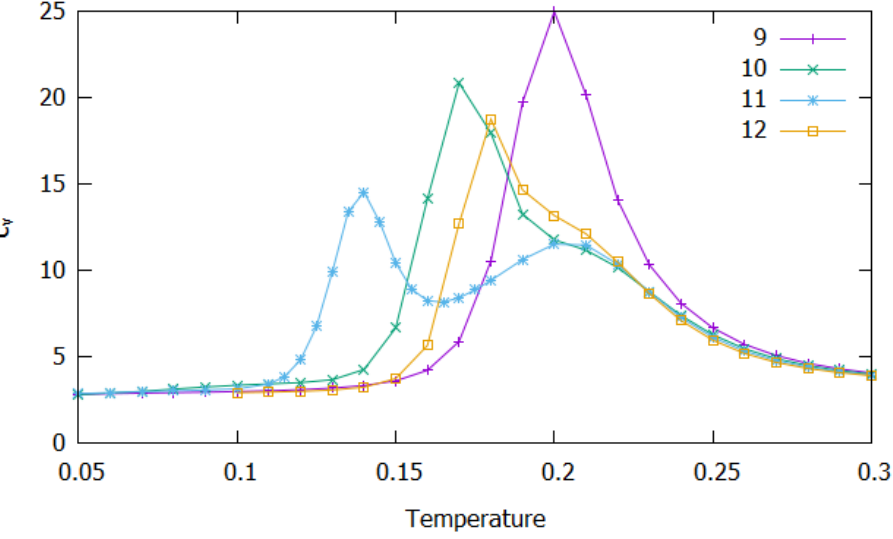
Figure 2. Reduced heat capacity as a function of temperature (in reduced units) for small cluster sizes: N = 9 (magenta); N = 10 (green); N = 11 (blue); N = 12